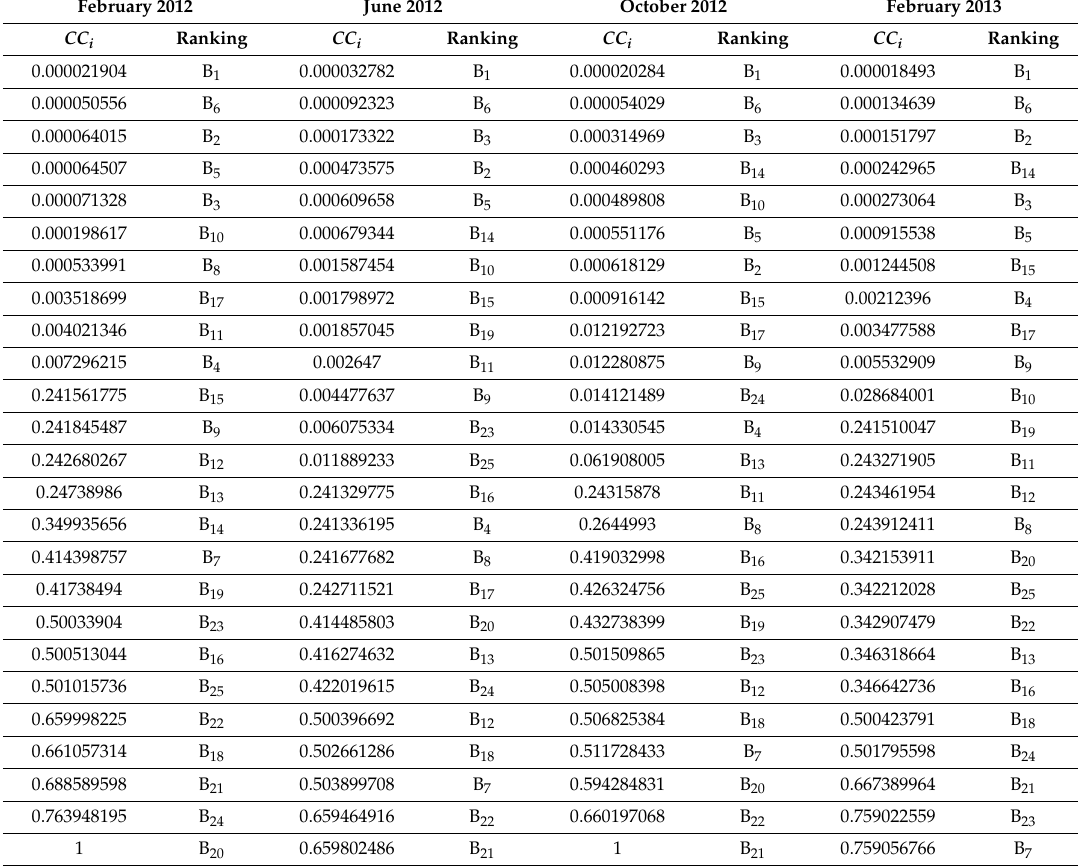
Table A4. Final bacteria rankings for the four periods of